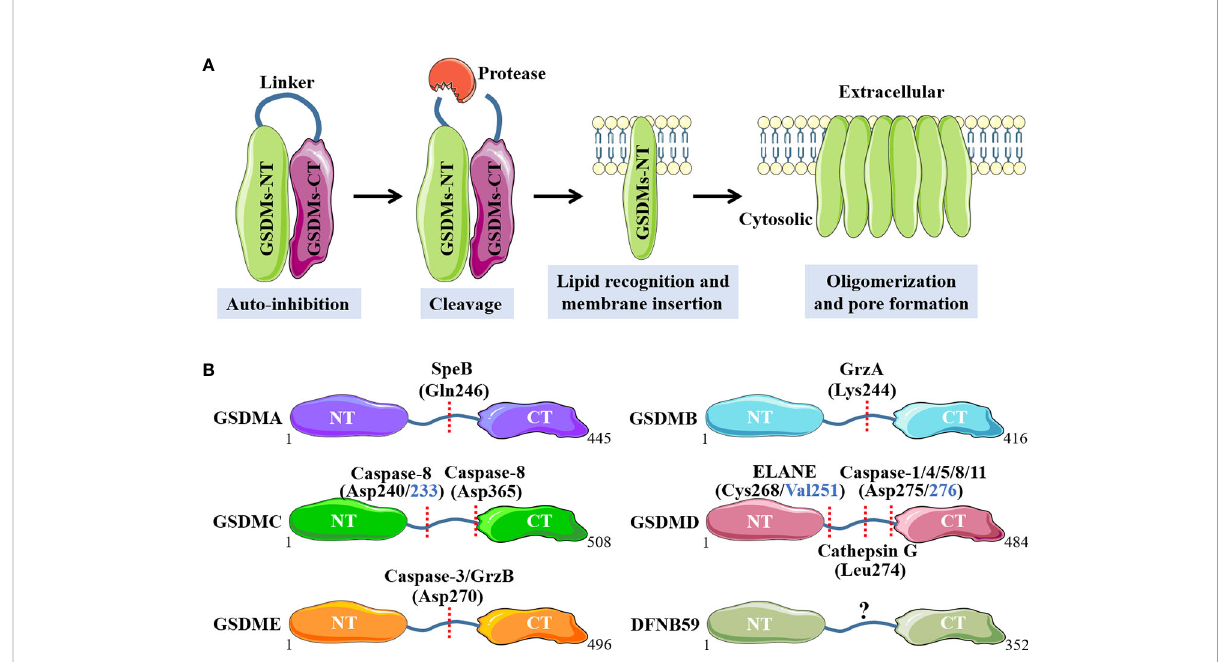
FIGURE 1 Molecular mechanisms of GSDMs that activated by speci fi c proteases. (A) . Main processes of GSDMs membrane pores formation. (B) . Respective proteases and cleavage sites for individual GSDMs. NT, N-terminal; CT, C-terminal; SpeB, streptococcal pyrogenic exotoxin B; GrzA, granzyme A; GrzB, granzyme B; ELANE, neutrophil